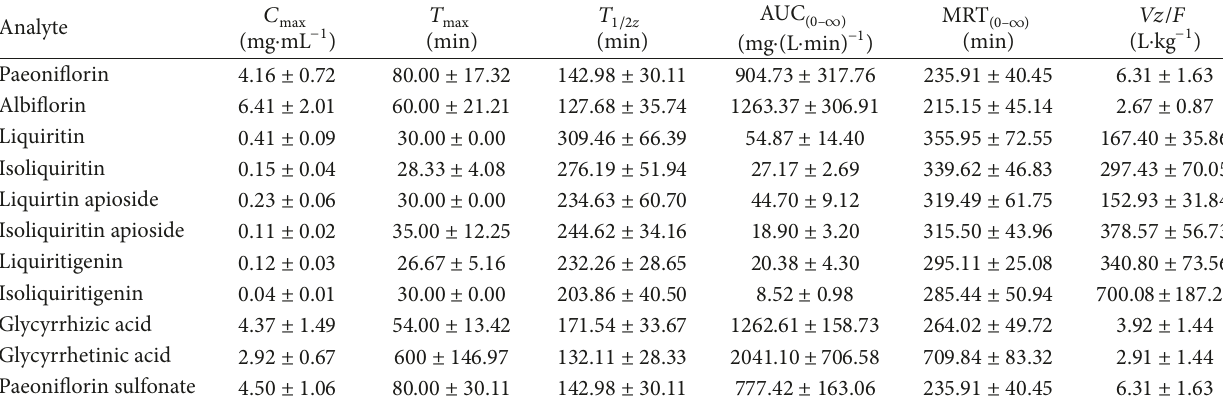
Table 8: Pharmacokinetic parameters of 11 compounds in rat plasma in Gualou Guizhi decoction ( 𝑛 = 6